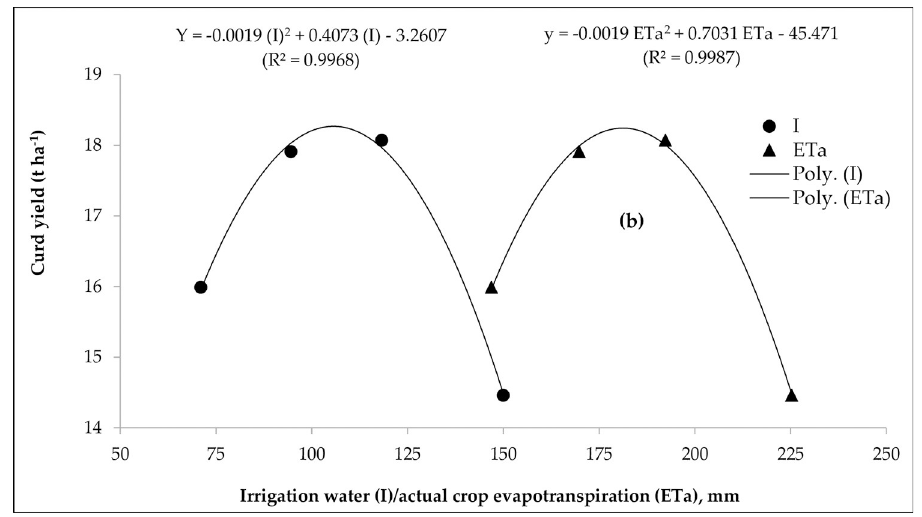
Fig 3. Relationship between (a) irrigation water (I) vs. curd yield and (b) actual crop evapotranspiration (ETa) vs. curd yield for broccoli for different levels and methods of irrigation (average data of